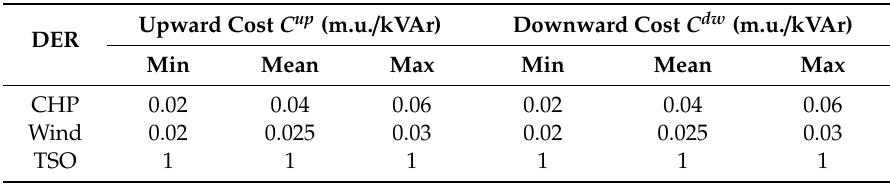
Table 4. DER reactive power